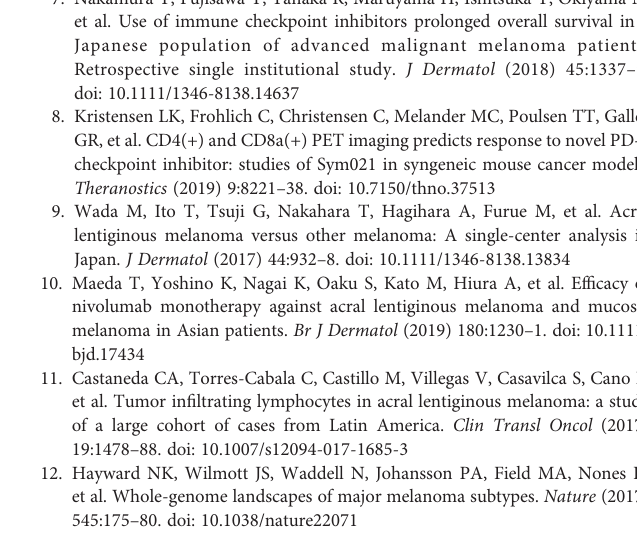
SUPPLEMENTARY FIGURE 2 | Immunohistochemical studies for FoxP3 in peritumoral skin/mucosa and distant normal skin/mucosa of each